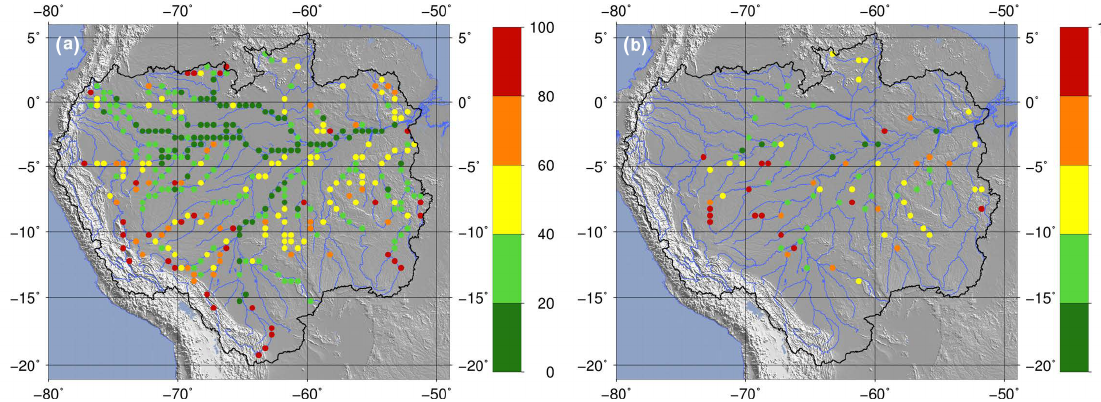
Figure 7. Analysis RMSEn for the SE1-direct experiment with respect to (a) the ENVISAT discharge and (b) the gauge